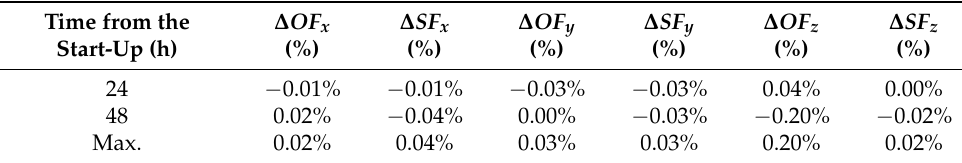
Table 8. Variation of the offset OF and the scale factor SF within 48 h. ∆ OF Time from the Start-Up (h)